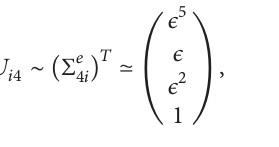
⋅ 𝛿 𝑚 = 100, 200, 400 GeV, 𝑚 𝑈 2 , for ] 󸀠 2 𝜇 (see (25)). Figure taken from